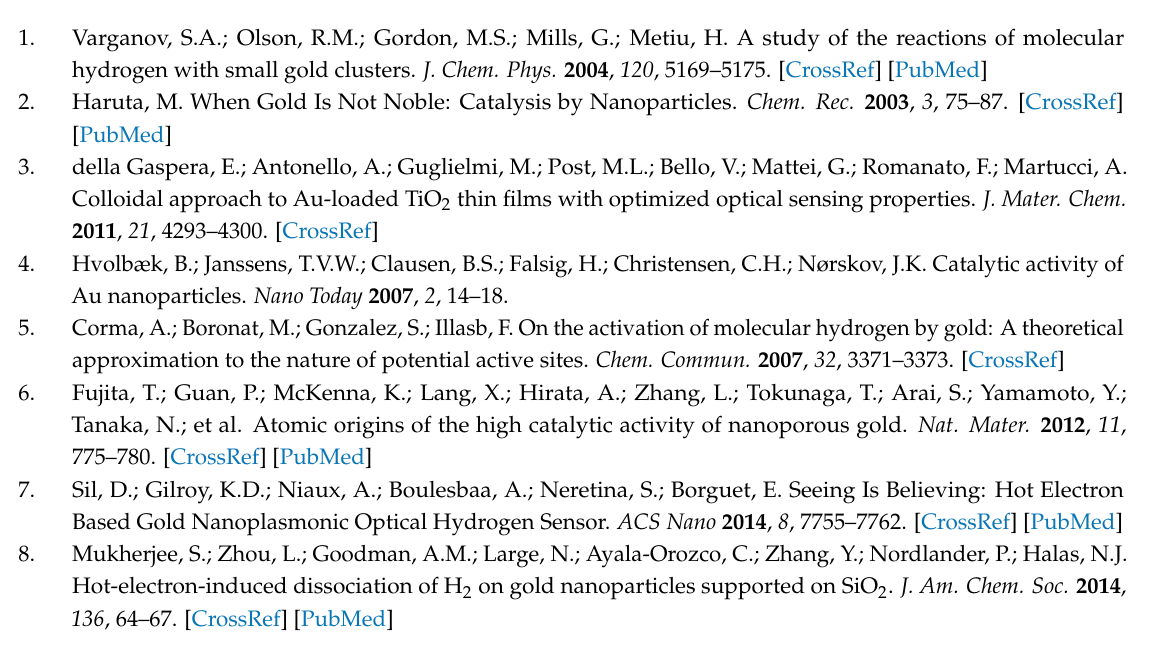
Figure S1: Absorption cross-section of a single Au ND as a function of wavelength and ND thickness for radius r = 150 nm (a), 75 nm (b), 50 nm (c), 25 nm (d), Figure S2, SEM images of masters used for samples with NDs diameters of 150 nm (left) and 50 nm (right). Scale bars are 1 µ m for both images, Figure S3, SEM images of the Au NDs array after (a) 30 ◦ C, (b) 150 ◦ C, (c) 250 ◦ C stabilization in air for 1 h. The mean diameter with the relative standard deviation are 166 ± 10 nm, 152 ± 9 nm, 143 ± 11 nm, respectively, Figure S4, Absorbance spectra of the Au NDs after stabilization at 30 ◦ C, 150 ◦ C and 250 ◦ C in air for 1 h, Figure S5, Refractive index (n) and extinction coefficient (k), respectively plotted in black and blue, for Au NDs in presence of inert atmosphere (nitrogen, solid curves) or hydrogen-rich atmosphere (5 vol% H 2 in Argon, dashed curves), Figure S6, XRD patterns for the (111) Bragg peak of Au NDs in presence of inert atmosphere (Argon, black curve) or hydrogen-rich atmosphere (5 vol% H 2 in Argon, red